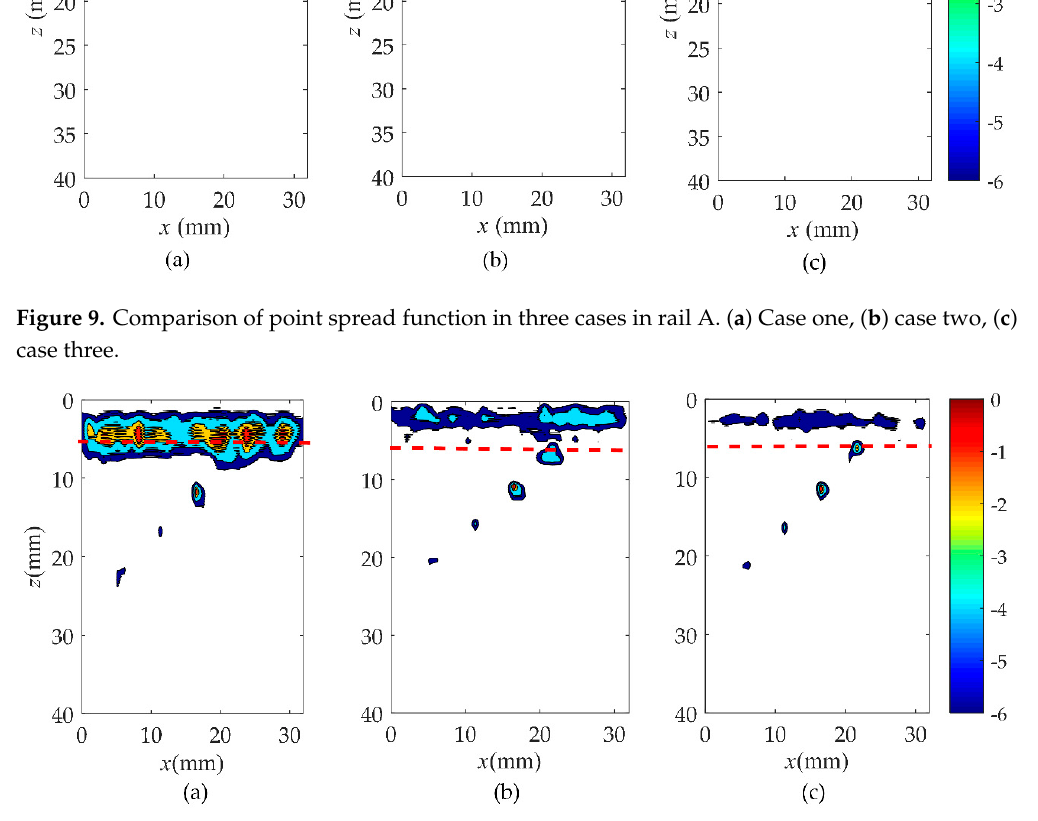
Figure 10. Comparison of point spread function in three cases in rail B. ( a ) Case one, ( b ) case two, ( c ) case three.